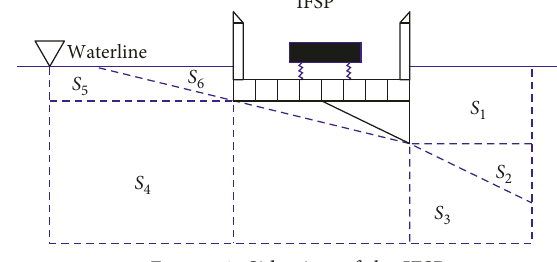
Figure 2: Side view of the IFSP.